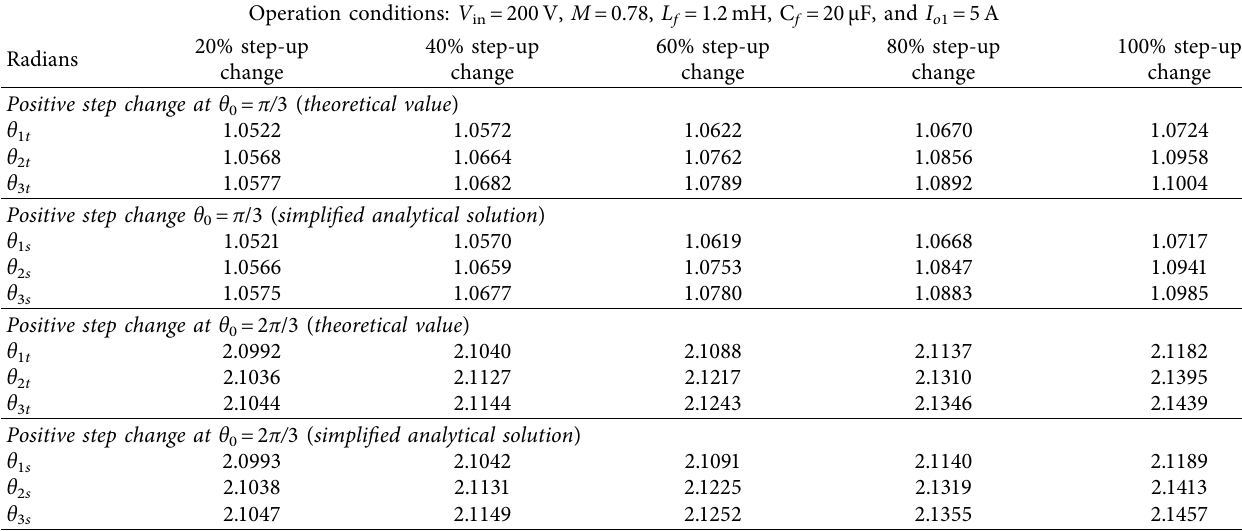
Table 1: Te theoretical value and simplifed calculation results for diferent step